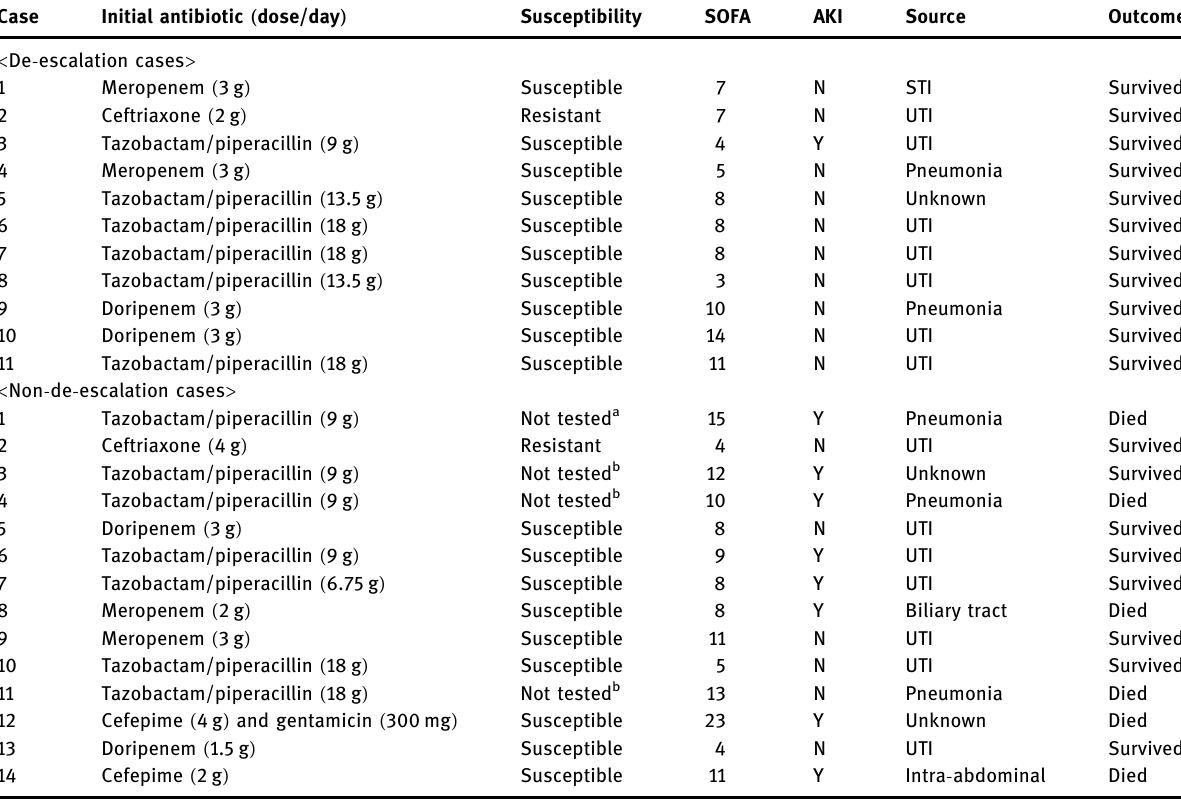
Table 1: Treatments, characteristics, and outcomes for 25 patients with sepsis due to ESBL - E bacteremia Case Initial antibiotic ( dose/day